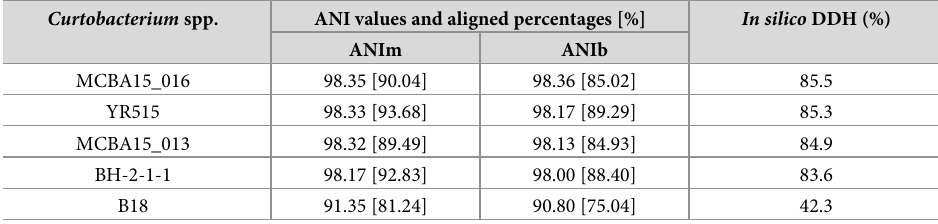
ANIm based on MUMmer ultra-rapid aligning tool; ANIb based on the BLAST